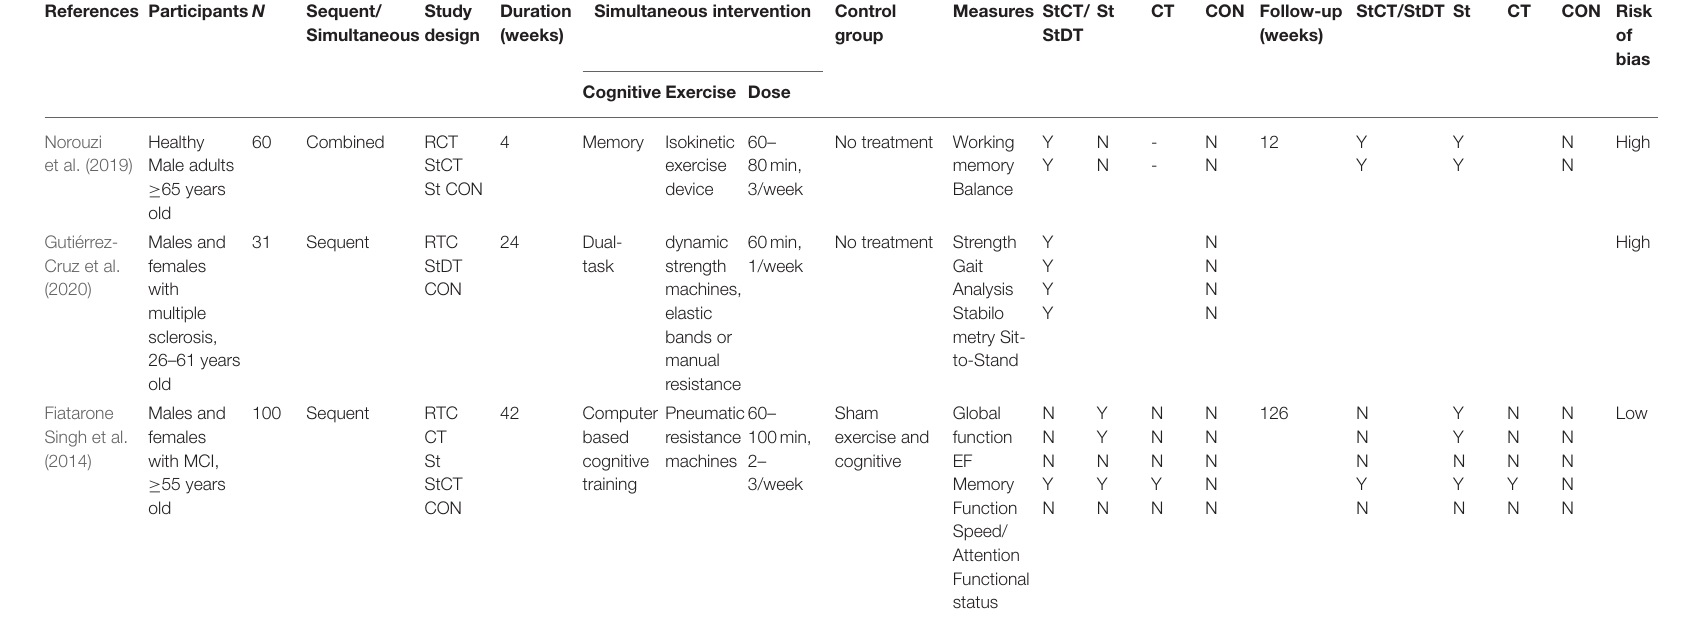
TABLE 1 | Summary of the available studies examined the effects of sequent or simultaneous strength-cognitive interventions in adults or older